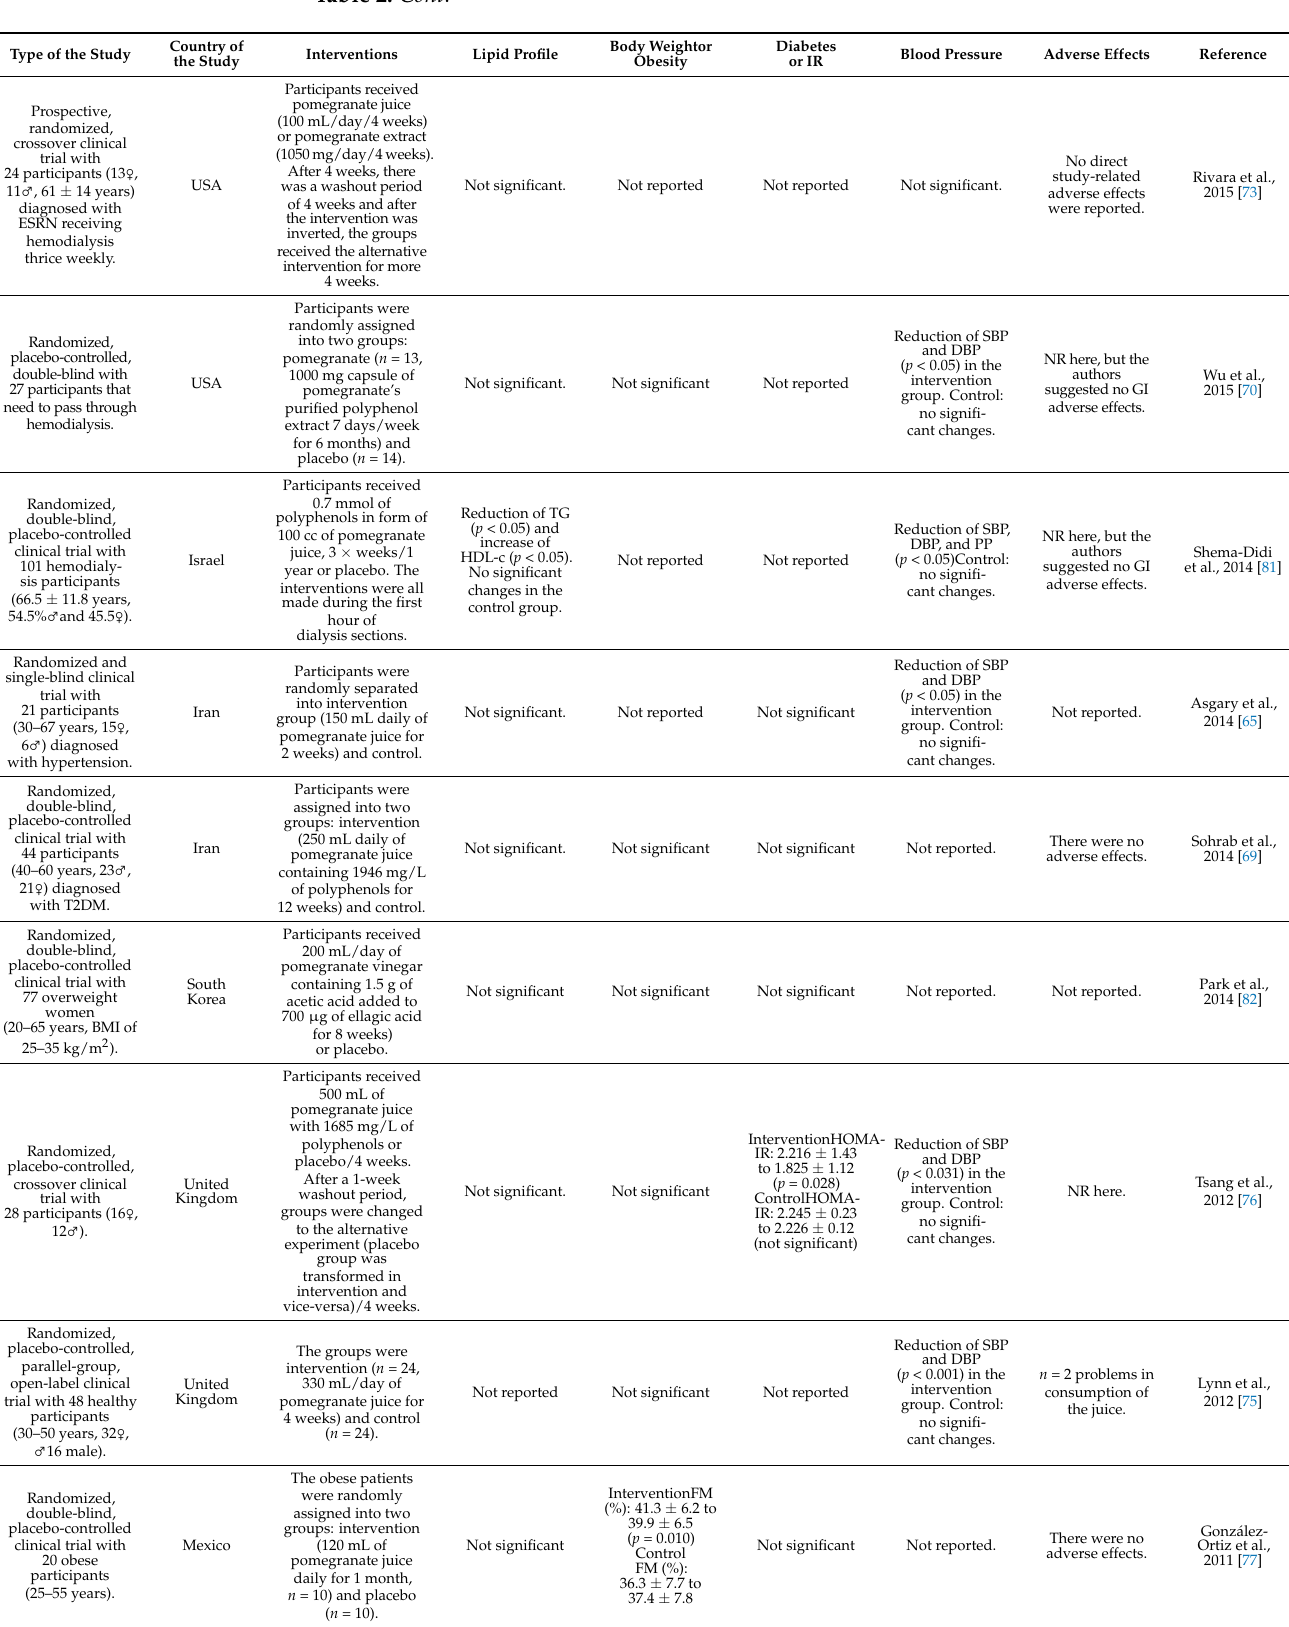
group. Control: nosignifi- cantchanges.